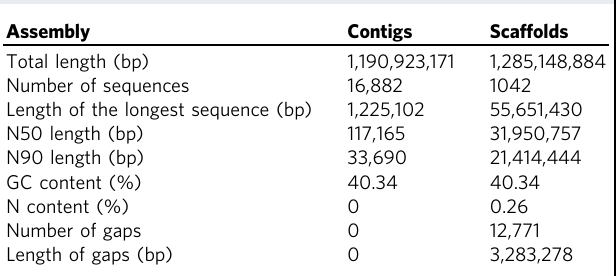
Table 1 Summary of the assembled genome of Amynthas cortices